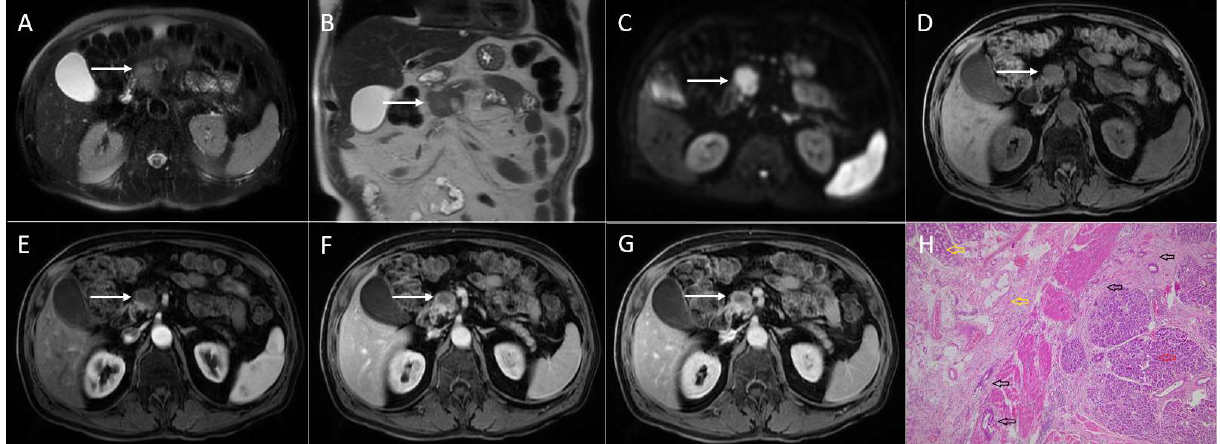
Figure 6. Pancreatic adenocarcinoma in 43-year-old women. Axial T2-weighted FS image ( A ) shows moderately hyperintense tumor ( arrow ) located in the pancreatic head. On coronal T2-weighted image ( B ), no obstruction of the main pancreatic duct is seen. The lesion ( arrow ) is hyperintense on DWI ( C ). On T1-weighted fat-suppressed image ( D ), the tumor is hypointense ( arrow ) and hypovascular in arterial phase ( E ), with discrete progressive enhancement in portal-venous phase ( F ) and delayed phase ( G ). Hematoxylin and eosin (H&E) staining ( H ) showed well-differentiated ductal adenocarcinoma ( black arrows ), which infiltrates pancreatic parenchyma ( red arrow ) and duodenal wall ( yellow arrows ); original magnification ×400.